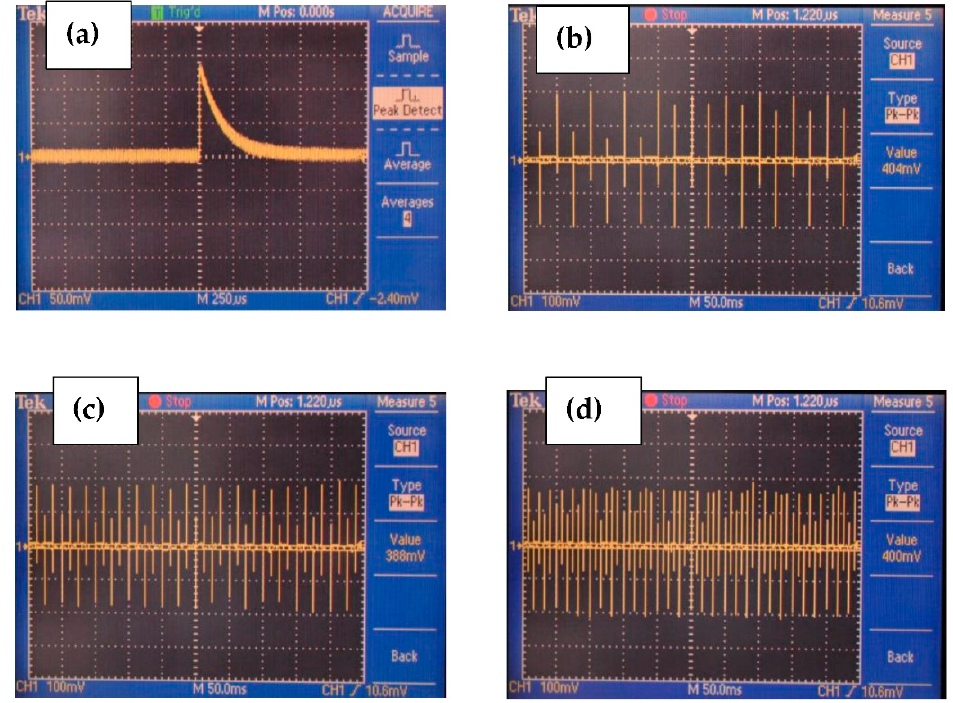
Figure 8. The voltage measured under bending force to the coaxial PBLG/PVDF fibers at different frequencies: ( a ) pulse signal at 20 Hz, ( b ) 20 Hz, ( c ) 40 Hz, and ( d ) 60 Hz.